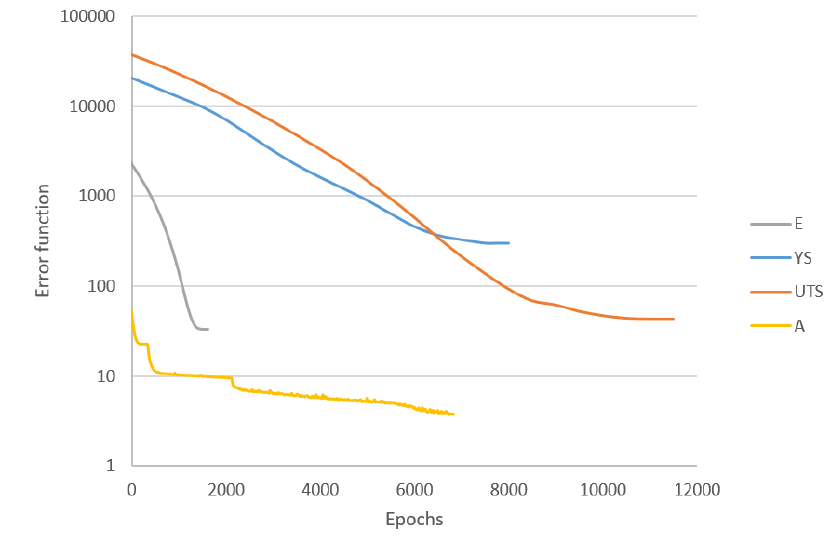
Figure A1. Averaged evolution of the error function during the training for each